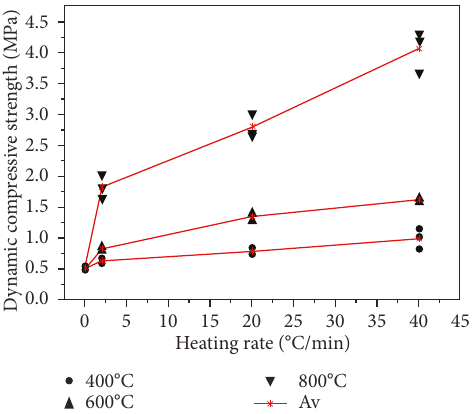
Figure 8: The correlation between peak strain and heating rate.